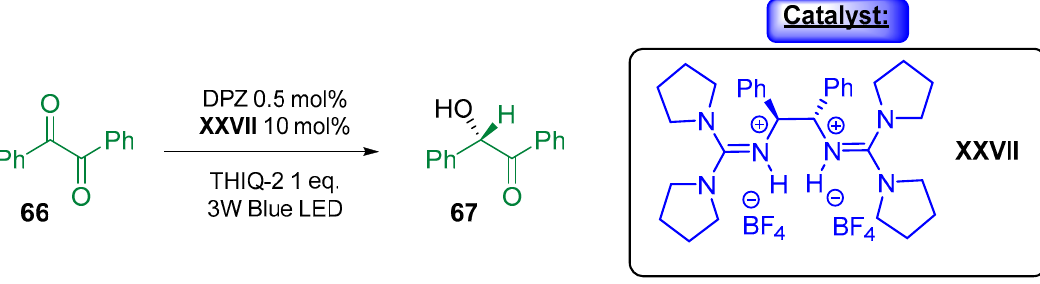
Scheme 25. Synergistic catalysis mediated by hydrogen bond thiourea-based catalyst and Ru-based